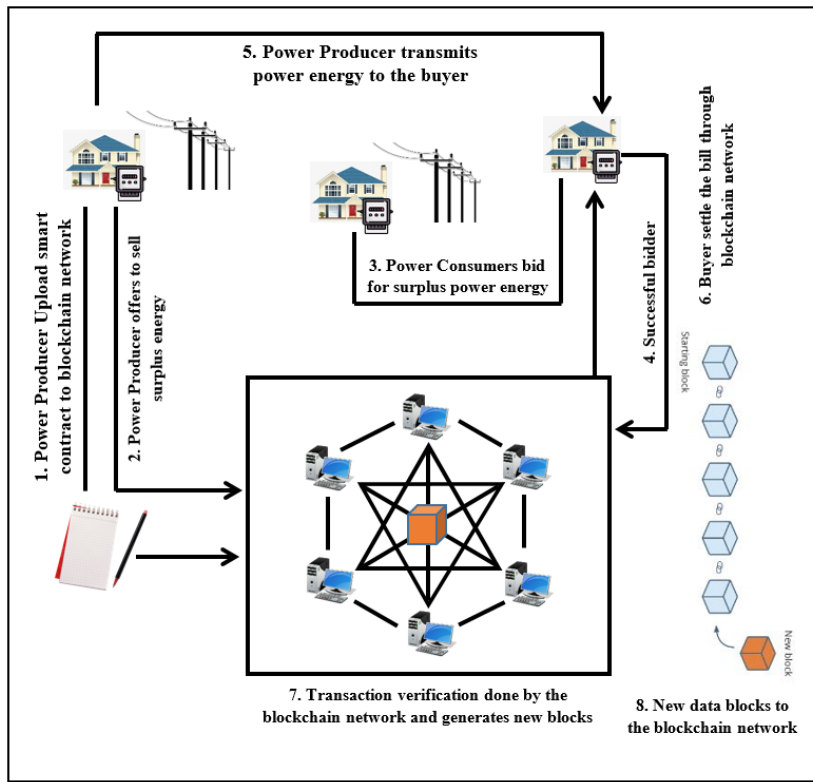
Figure 3: Power Energy Trading